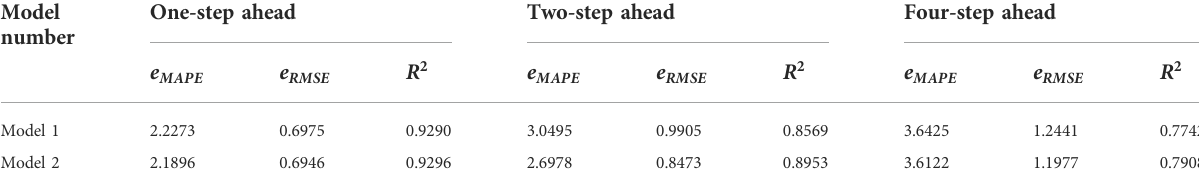
TABLE 5 Prediction results of models without decomposition technique (Case I).